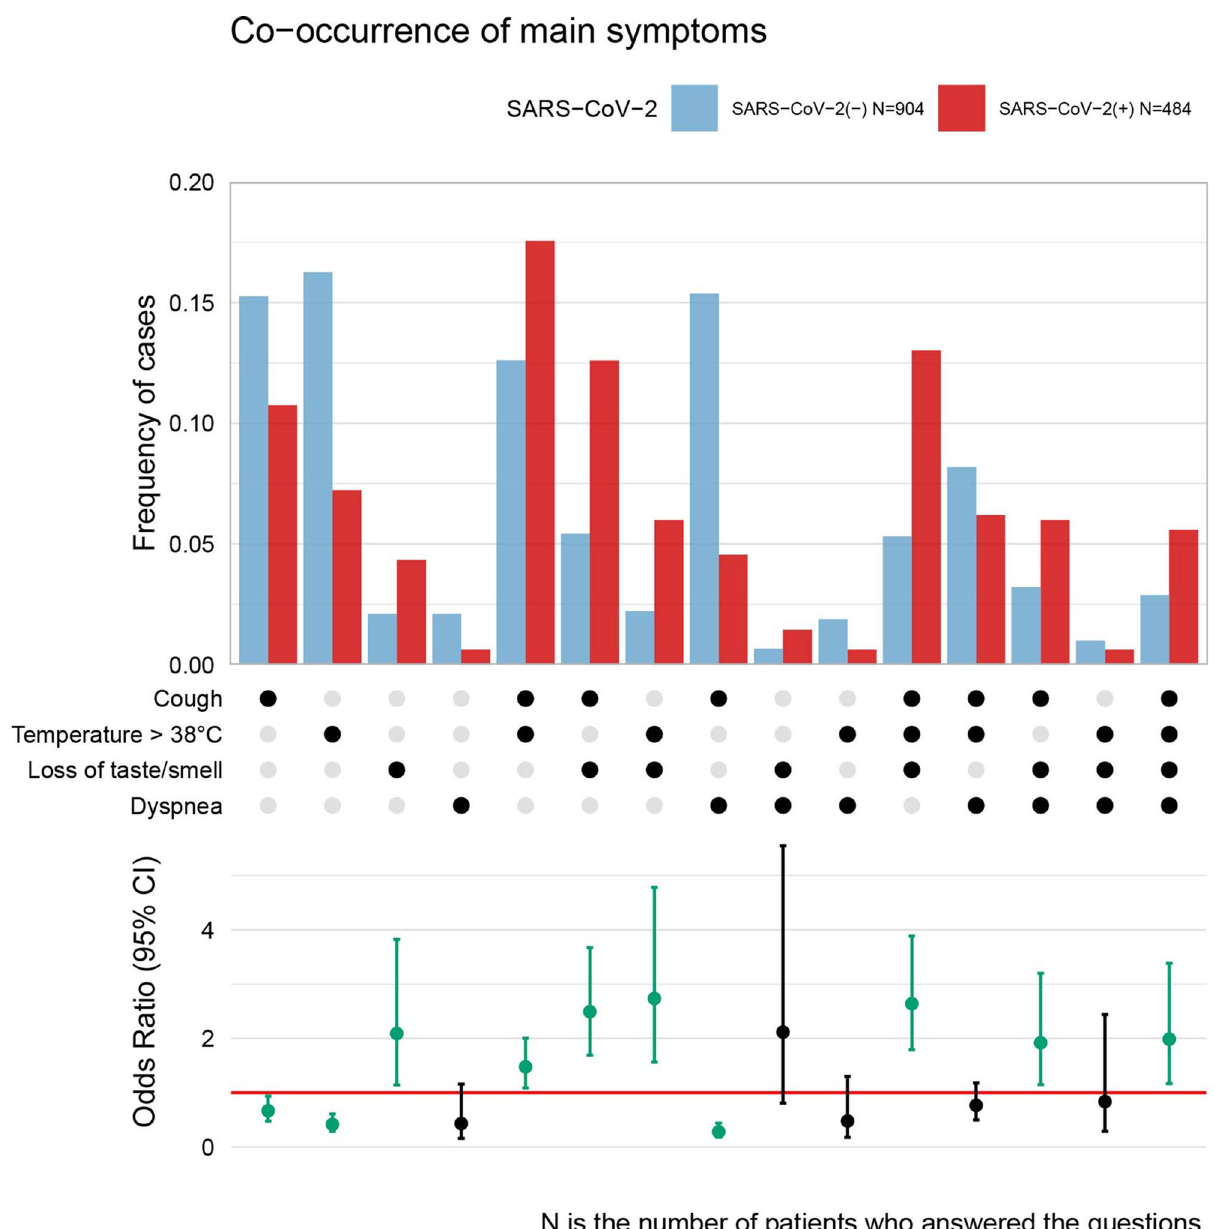
Figure 3. Frequency of patients observing one symptom or a combination of symptoms regarding the total number of patients from a certain group (infected or not infected with SARS-CoV-2) who answered all four analysed queries. Dots in the middle part indicate which symptom or combination of symptoms the bars in the upper part of the plot refer to. For example, about 15% of patients with negative COVID-19 diagnosis reported only cough (and no high temperature, no dyspnea, no loss of taste/smell), whereas, from the group of patients with a positive diagnosis, about 11% of patients reported only cough (no other symptoms from the list). The lower part of the plot shows the odds ratio with 95% confidence intervals for comparison of SARS-CoV-2 diagnosis with a corresponding symptom or symptom combination. The red line shows the level of odds ratio equal to 1. Significant odds ratios ( p < 0.05) were coloured